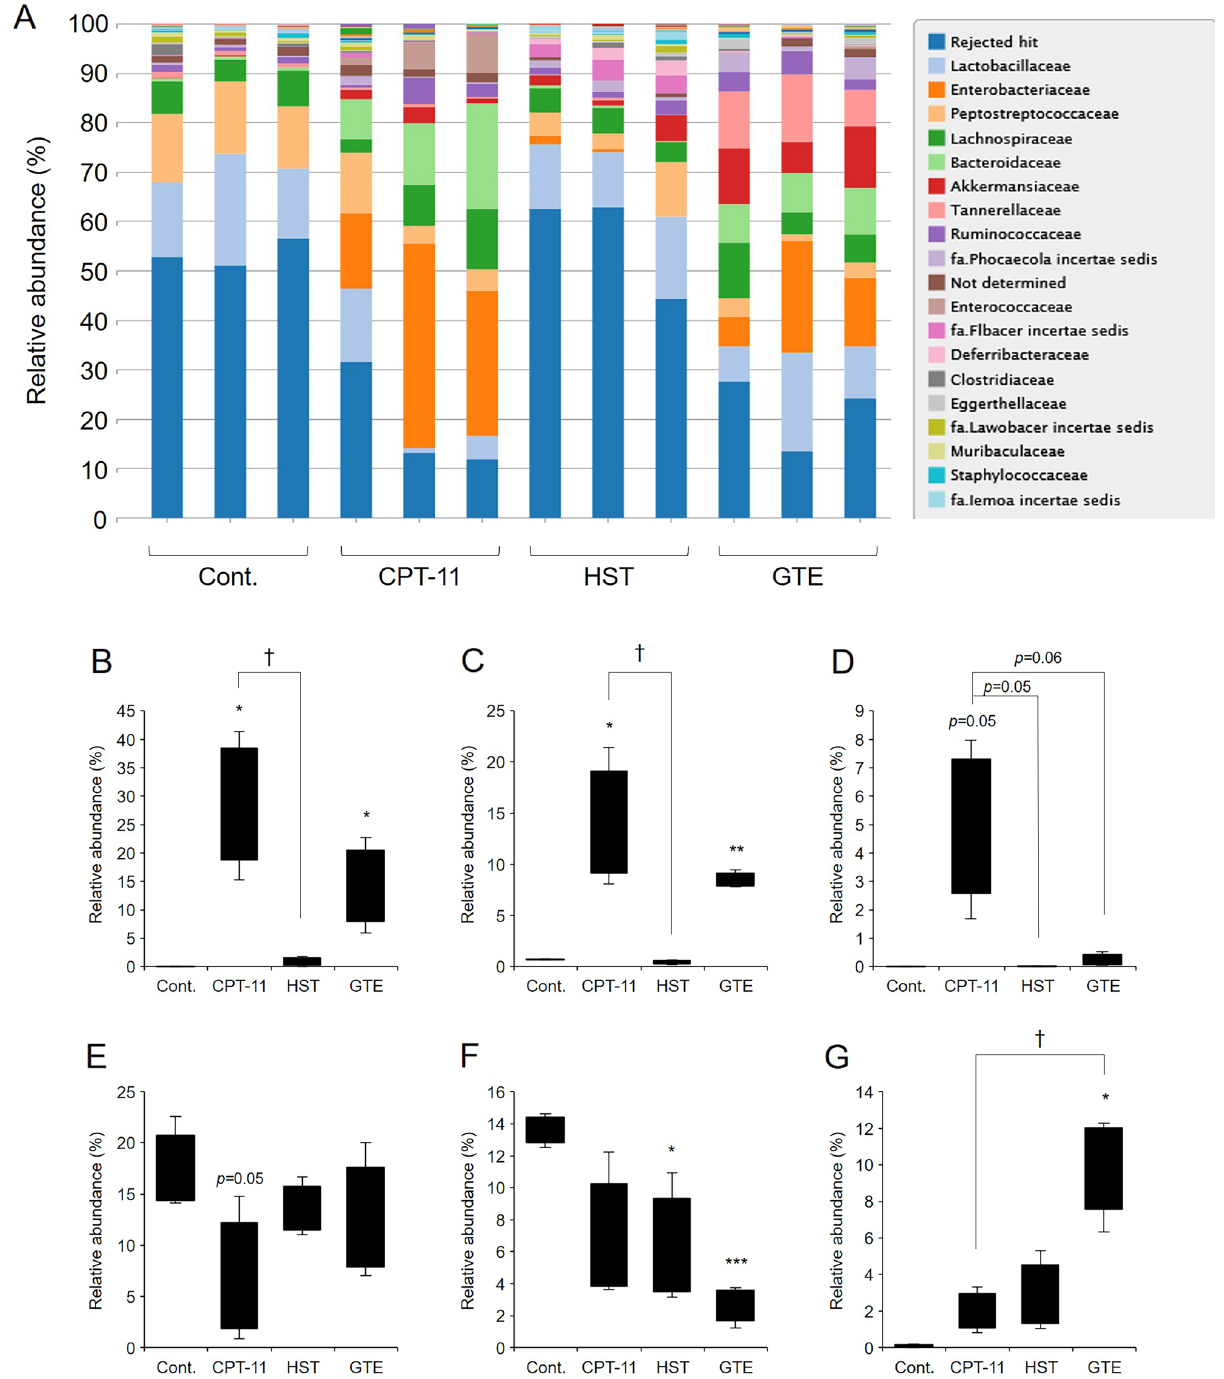
Figure 6. Relative abundance at the family level in the gut microbiota. Rats were administered CPT-11 or lactic acid buffer intravenously for 4 days, and HST or GTE was administered in combination. The relative abundance at the family level in the gut microbiota was measured by next-generation sequencing ( A ). Boxplots showing Enterobacteriaceae ( B ), Bacteroidaceae ( C ), Enterococcaceae ( D ), Lactobacillaceae ( E ), Peptostreptococcaceae ( F ), and Akkermansiaceae ( G ) of taxonomic abundance at the family level (mean ± S.D., n = 3, * p < 0.05, ** p < 0.01, *** p < 0.001 vs. Cont., † p < 0.05 vs.